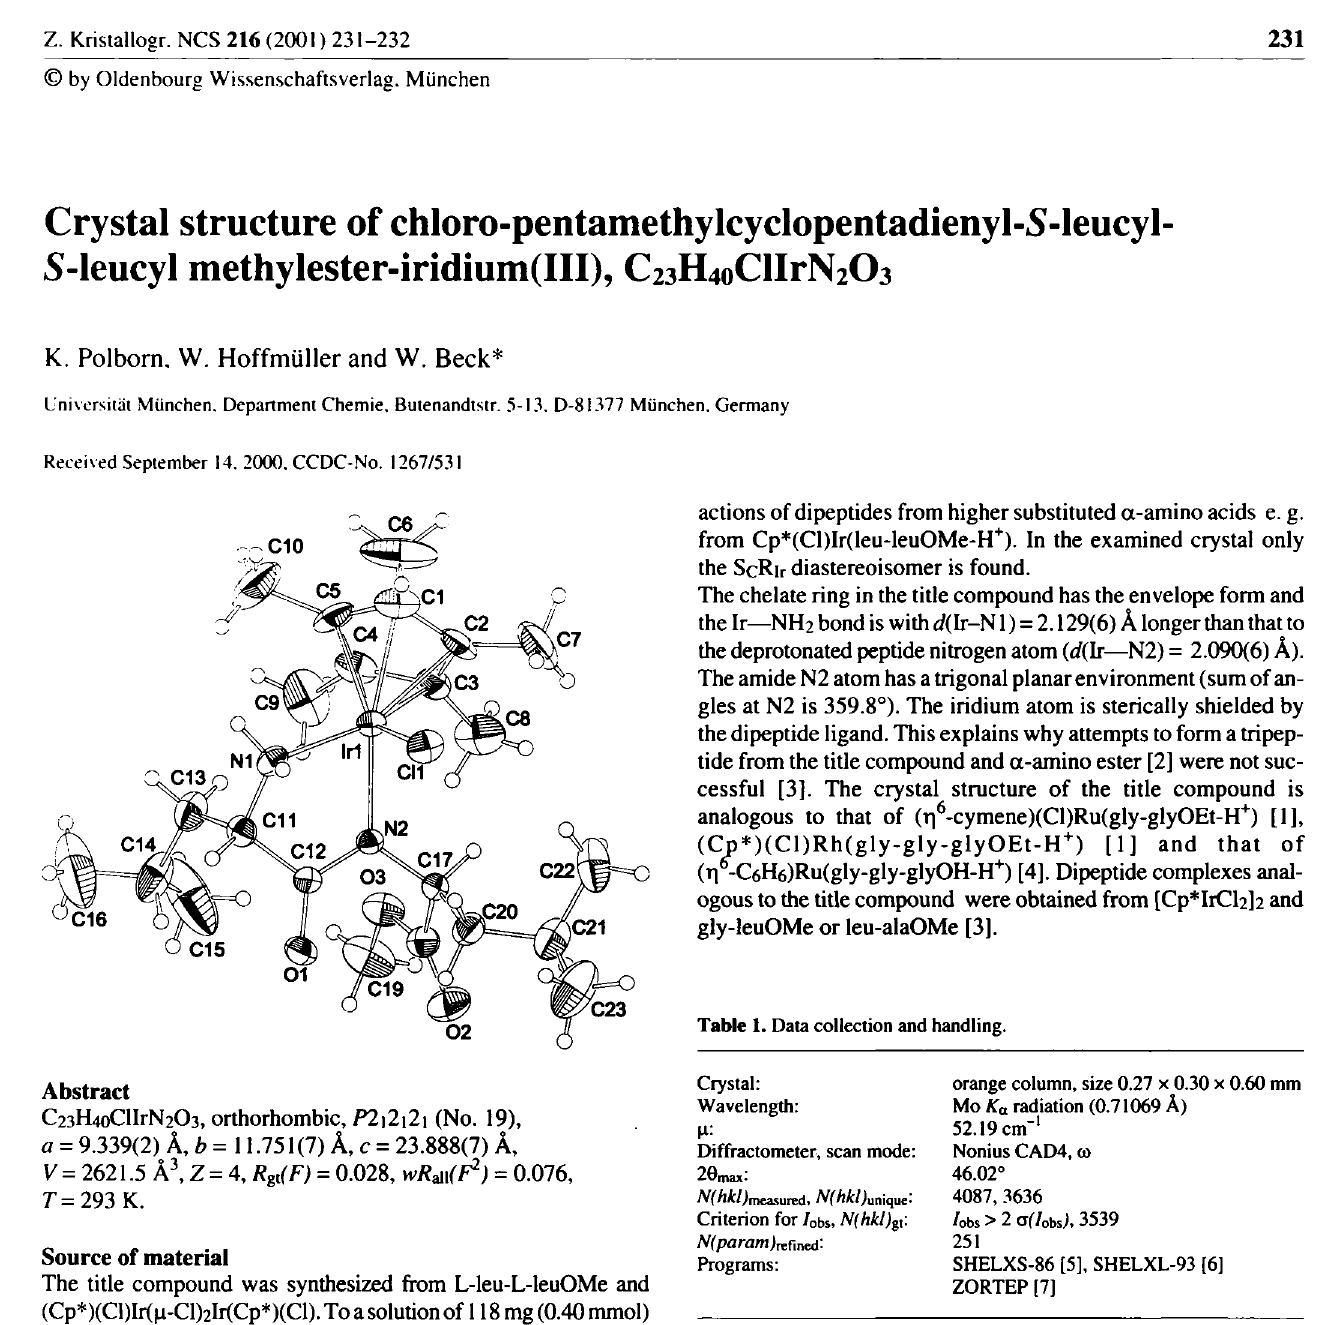
Table 1. Data collection and handling.